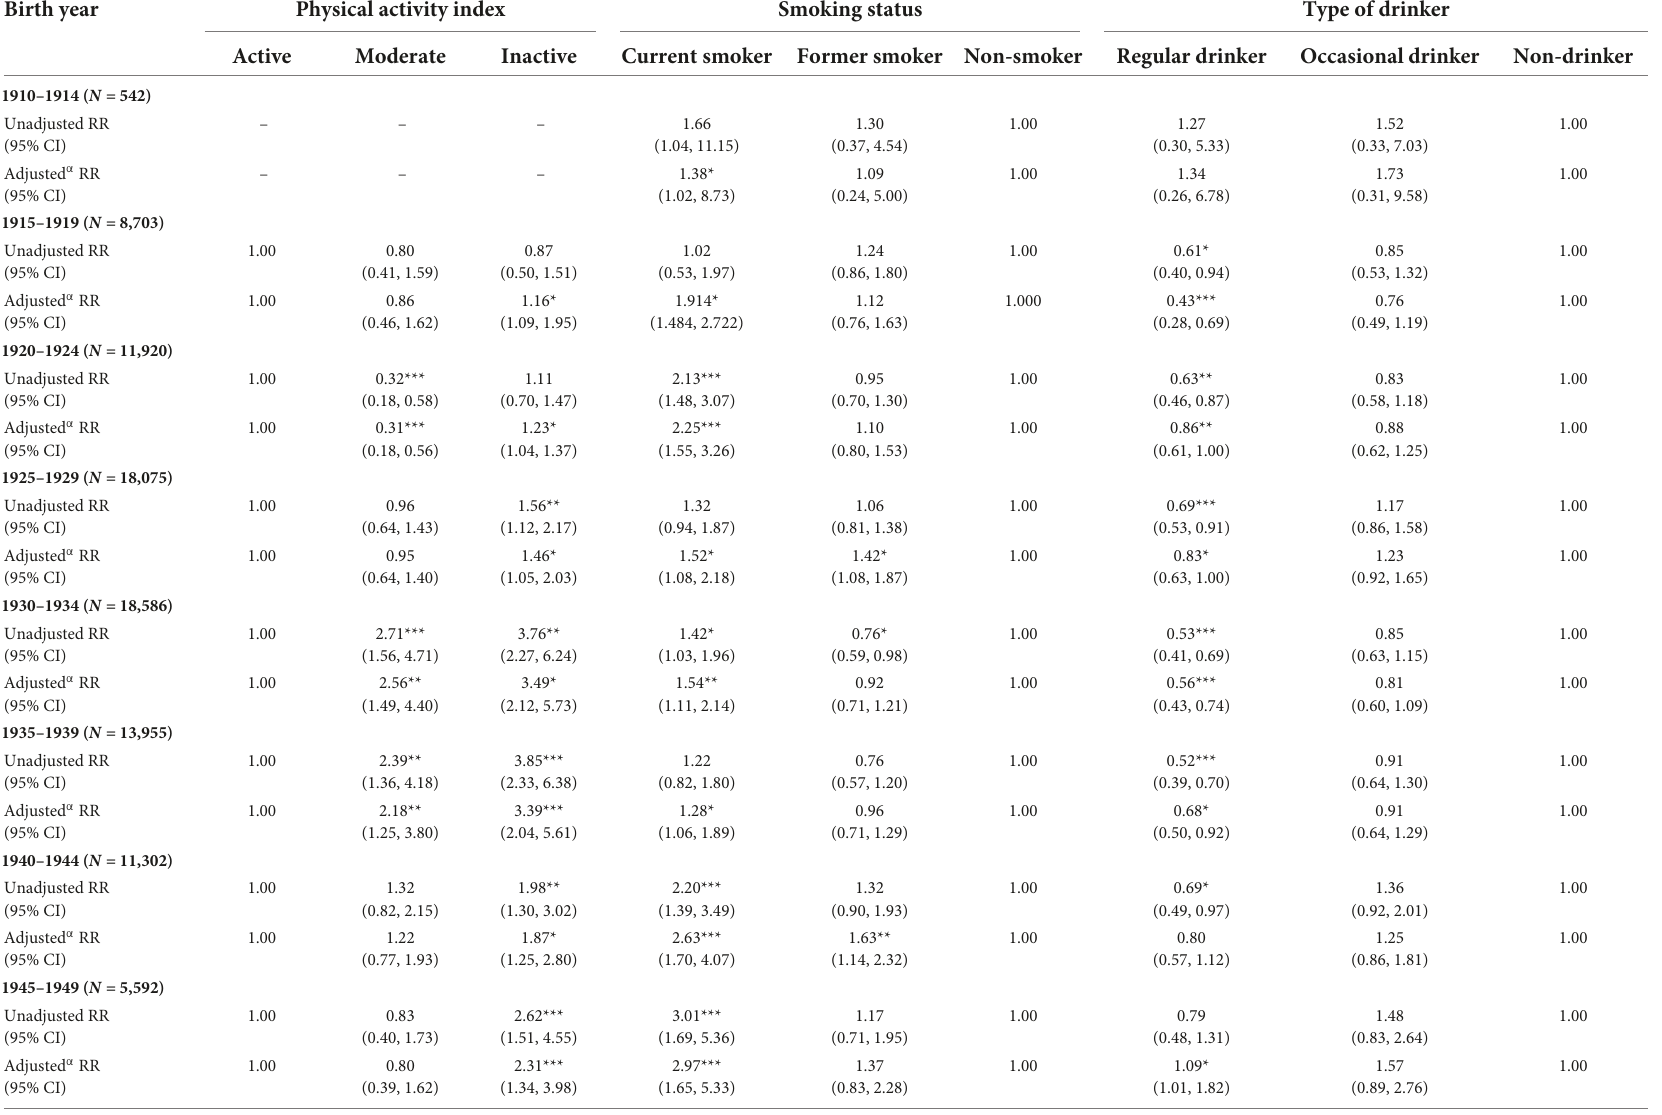
TABLE 4 Unadjusted and adjusted relative risk of depression by physical activity index, smoking status, and type of drinker across eight birth cohorts for Canadian residents